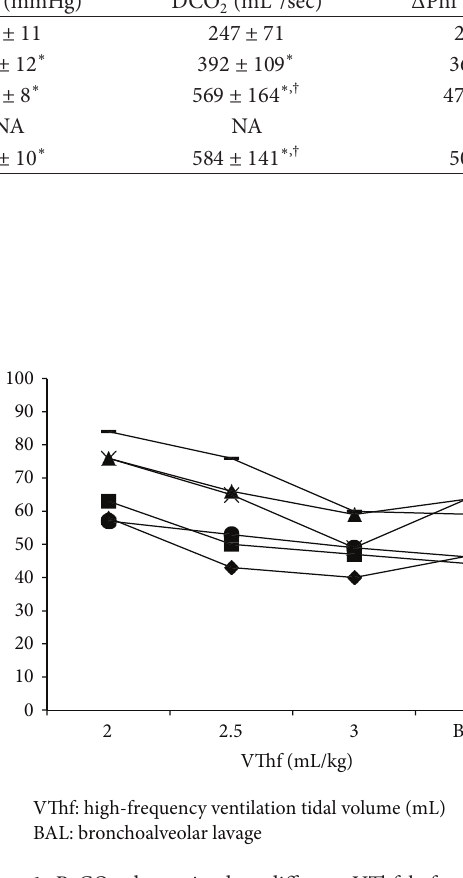
Figure 1: PaCO 2 determined at different VThf before and after surfactant depletion by bronchoalveolar lavage